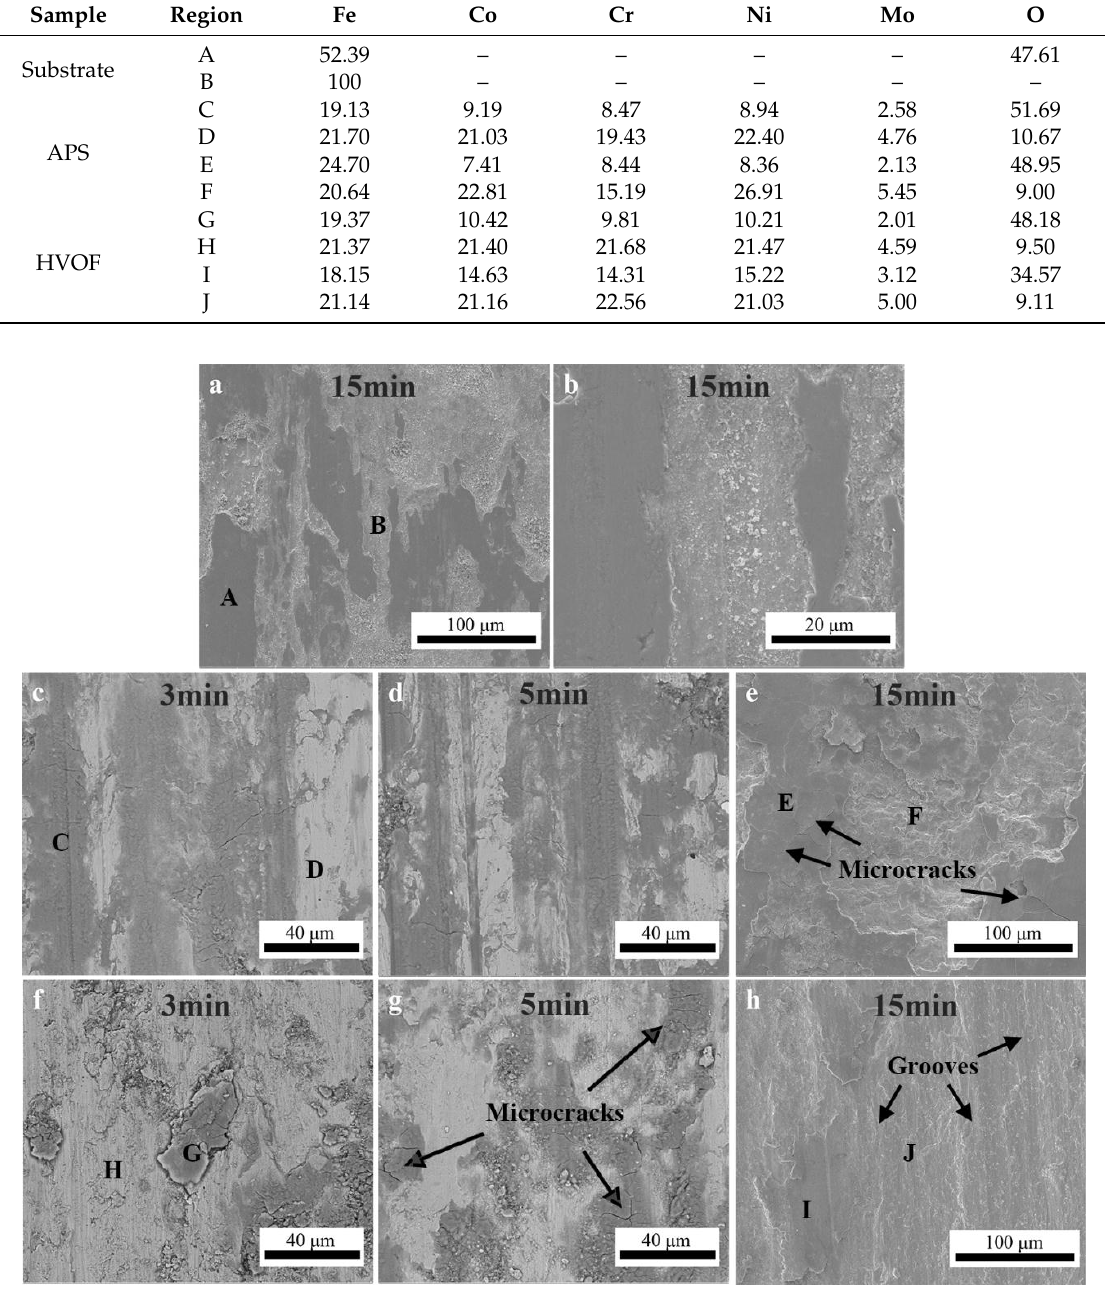
Table 6. EDS analysis results of the worn surface of the FeCoCrNiMo0.2 coatings and the substrate.